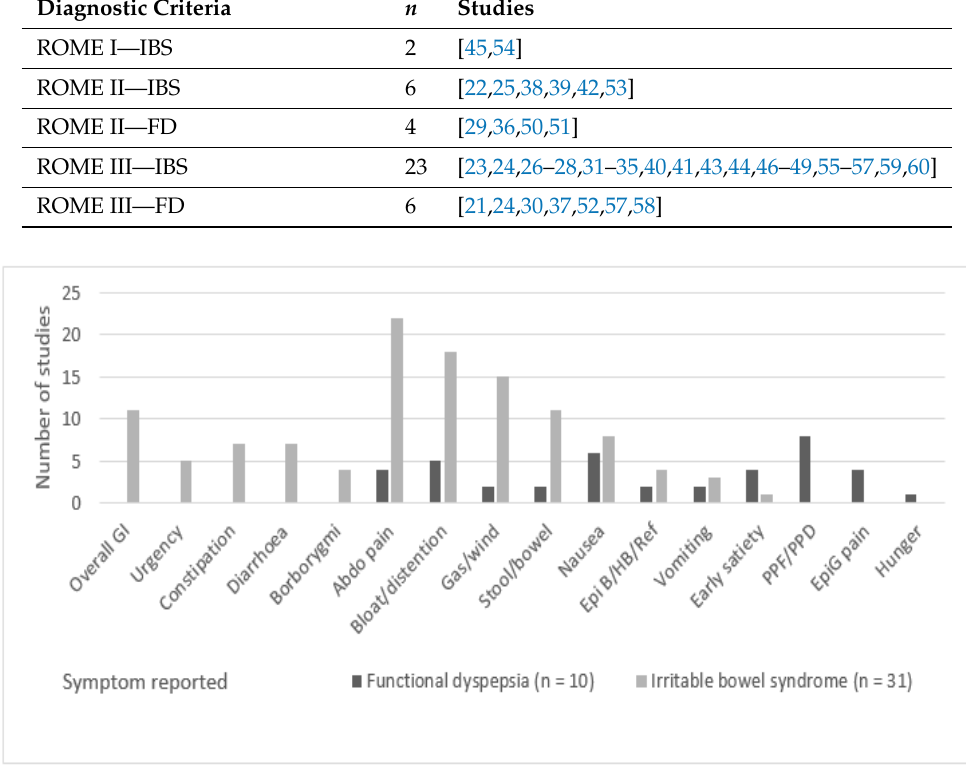
Table 3. Diagnostic criteria used in studies that assessed the relationship between food and functional gastrointestinal disorders.